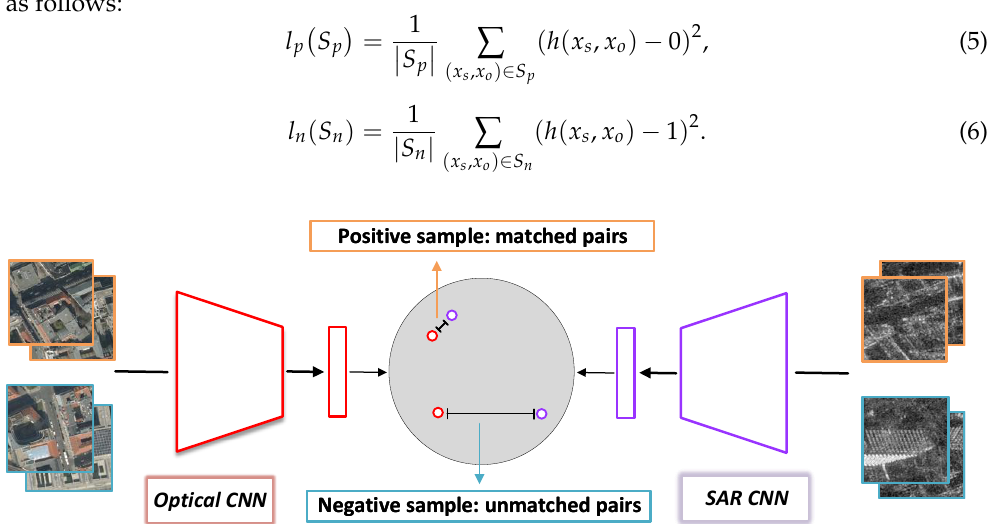
Figure 4. Schematic illustration of the BNN architecture for the SAR-optical image matching task. Optical network and SAR network are used in BNN to project the images from different modalities into a common subspace. The Euclidean distance of the representations of SAR and optical images is pulled close for positive samples and pulled apart for negative